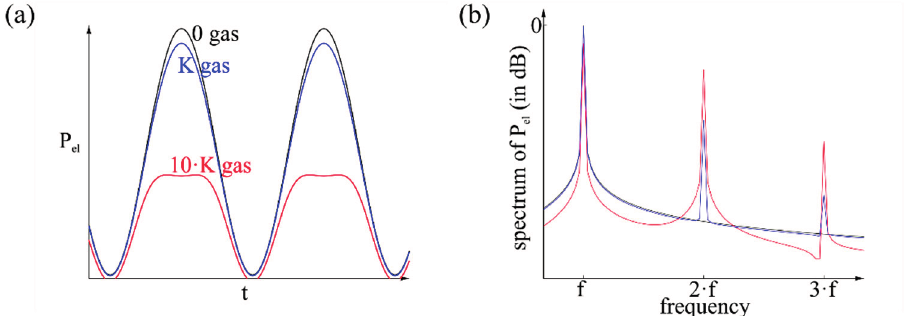
Figure 6. ( a ) Trend of the wave related to the time and ( b ) spectrum of the signal, both without gas, with the gas concentration K and with the gas concentration of 10 K